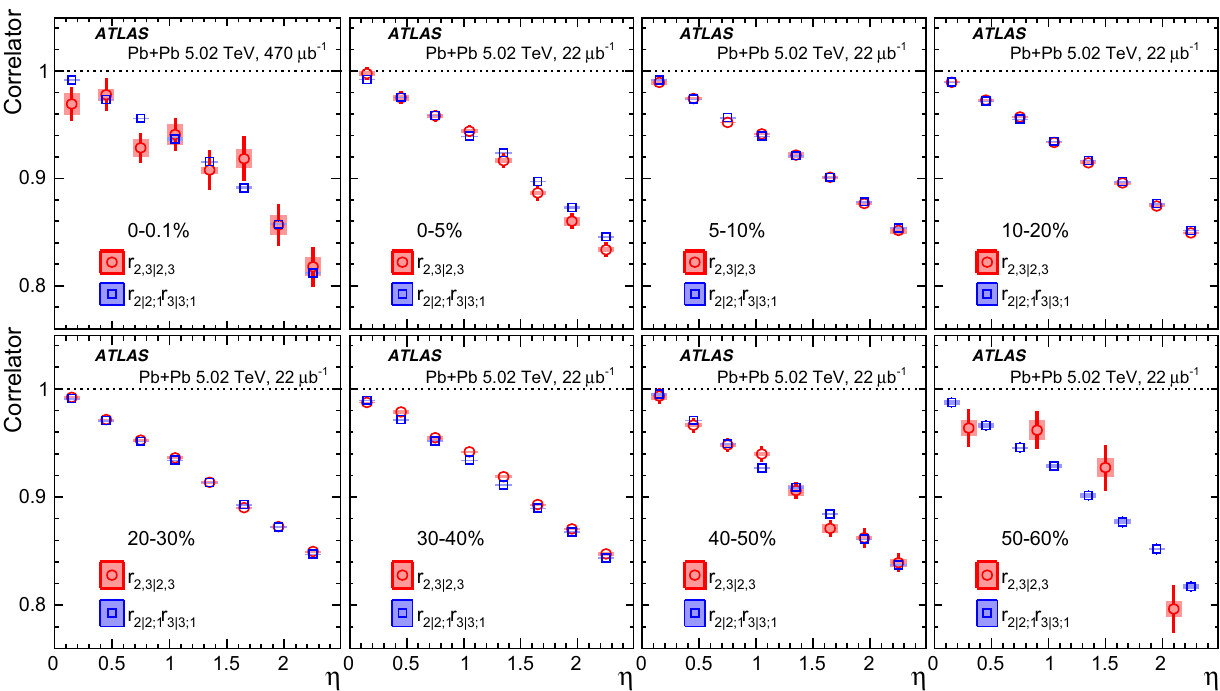
Fig. 21 The r 2 , 3 | 2 , 3 (circles) and r 2 | 2 ; 1 r 3 | 3 ; 1 (squares) as a function of η for several centrality intervals. The error bars and shaded boxes are statistical and systematic uncertainties, respectively. The r 2 , 3 | 2 , 3 data in the 50–60% centrality interval are rebinned to reduce the uncertainty